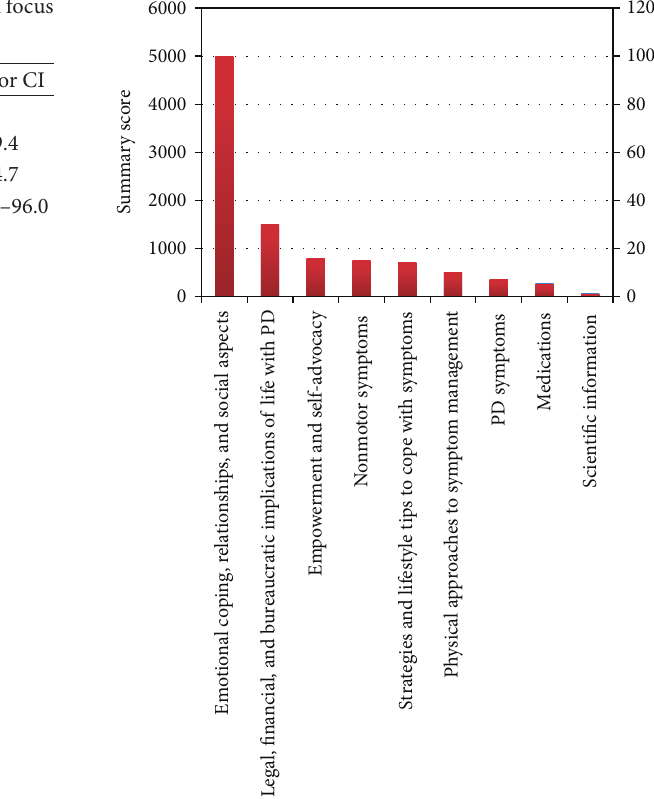
T 1: Demographic characteristics of PwP participating in focus